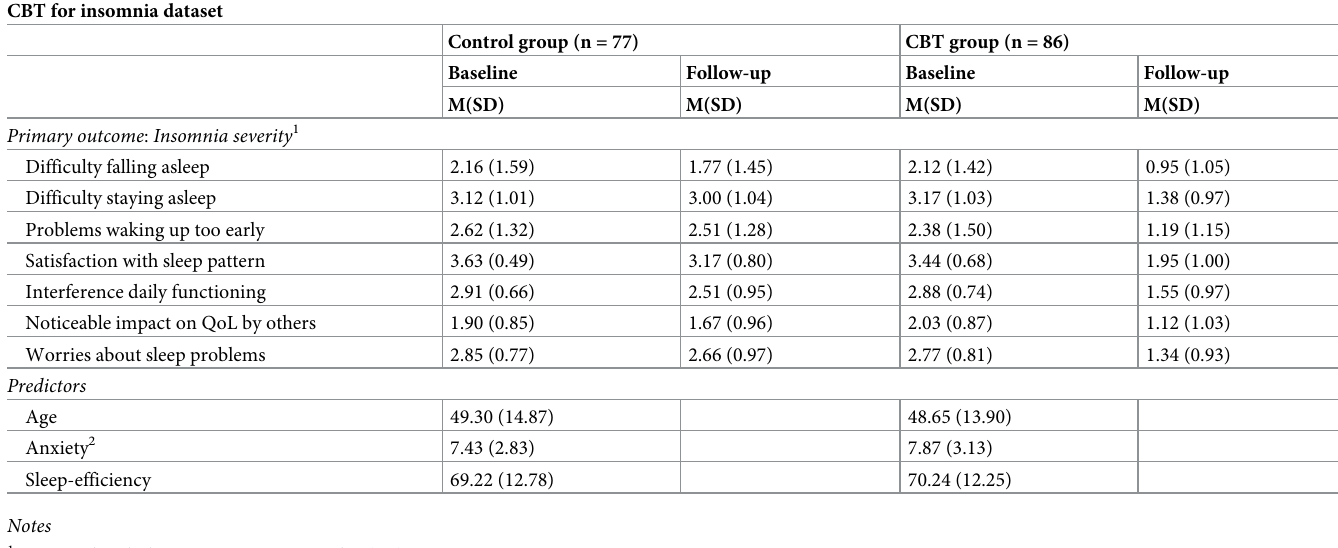
Table 1. Means and standard deviations of the primary outcome and predictors used for response shift analyses of the CBT for insomnia dataset.